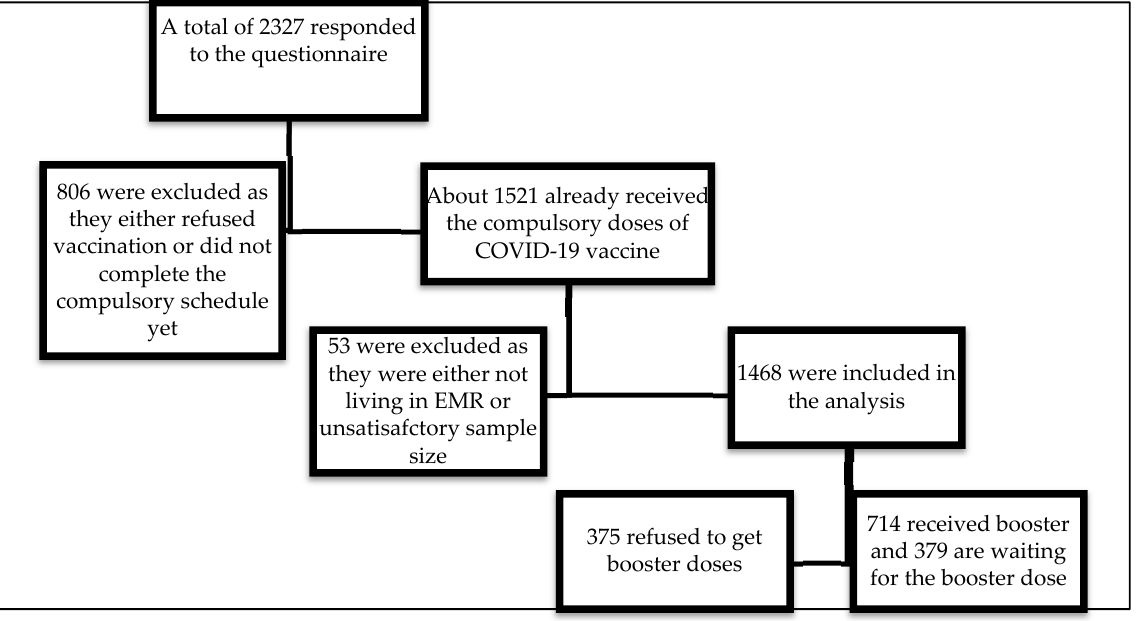
Figure 1. The flow chart of the sampling process.